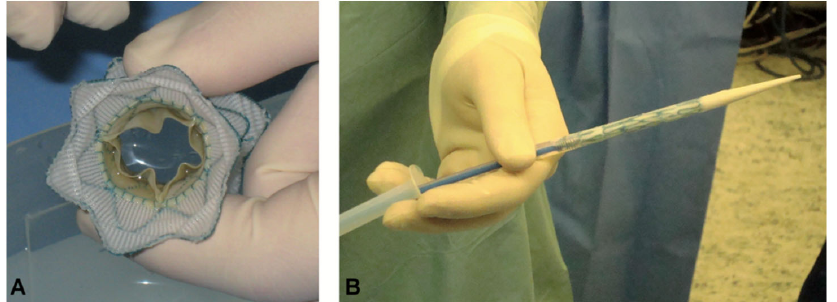
Figure 2. New device: ( A ) An end ‐ on ‐ view of the new device showing the Nitinol stent with graft covering and the open pericardial valve leaflets. ( B ) The delivery system with the device crimped and loaded onto the distal end (right side of picture) [30] .